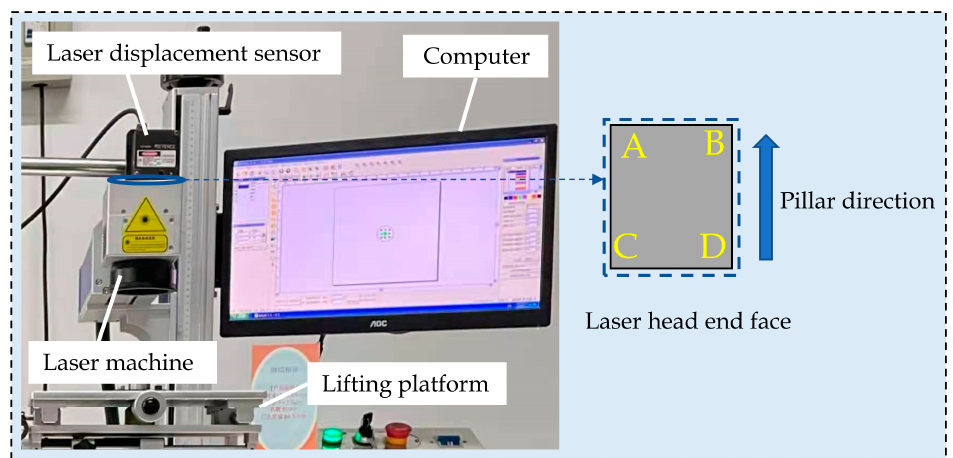
Figure 9. Physical drawing of vibration displacement test in the external environment. According to Equation (12), the vibration displacements at points A and B of the laser machine were smaller than those at points C and D, due to differences in the arm length.